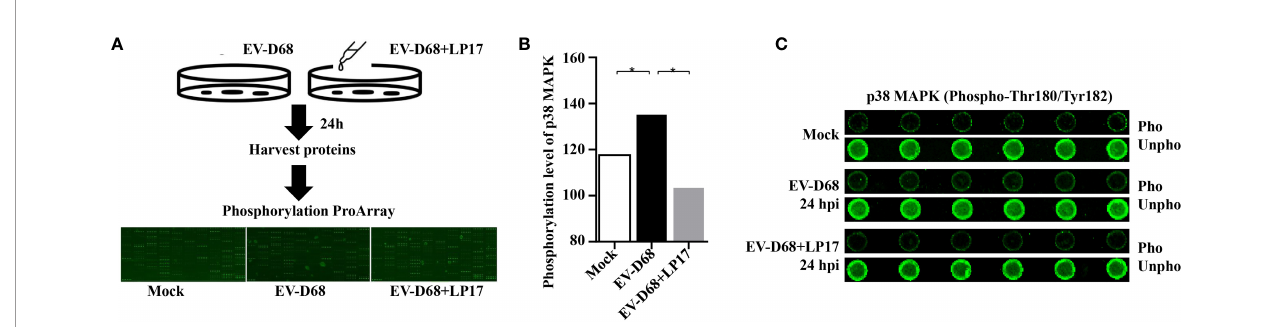
FIGURE 7 | Activated TREM-1 signals through the p38 MAPK pathway. (A) Flow chart of Phosphorylation ProArray (CSP100_plus) detection. The experiment included six replicates (horizontal rows) of phospho-speci fi c and total antibodies, which were assessed against different treatment groups. (B, C) The graph shows the levels of TREM-1 downstream p38 MAPK phosphorylation level for Mock, EV-D68, and EV-D68+LP17 groups. * p < 0.05.